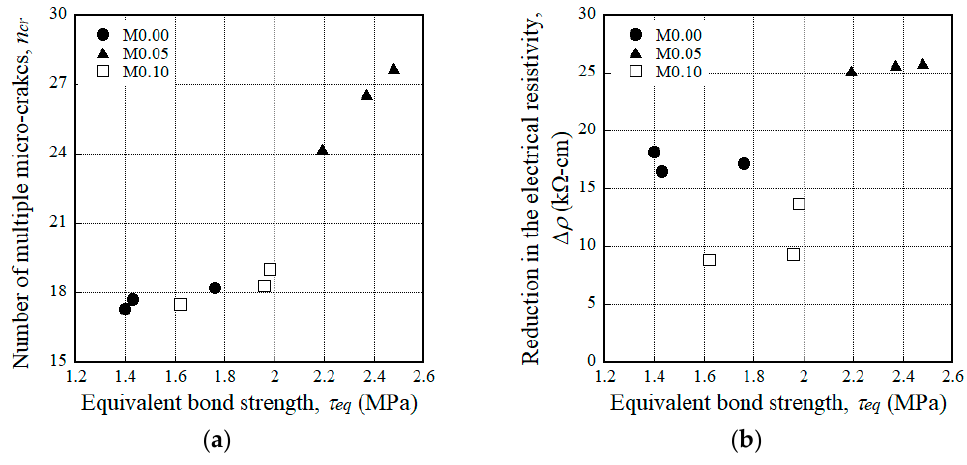
Figure 14. Effects of the equivalent bond strength on ( a ) the number of multiple micro-cracks and ( b ) the reduction in the electrical resistivity.